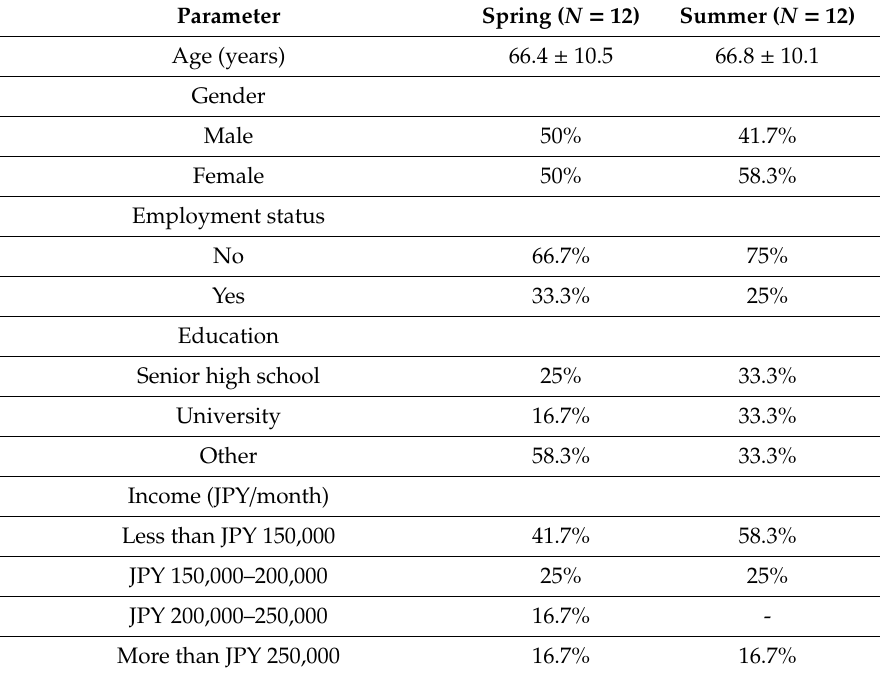
Table 2. Participant